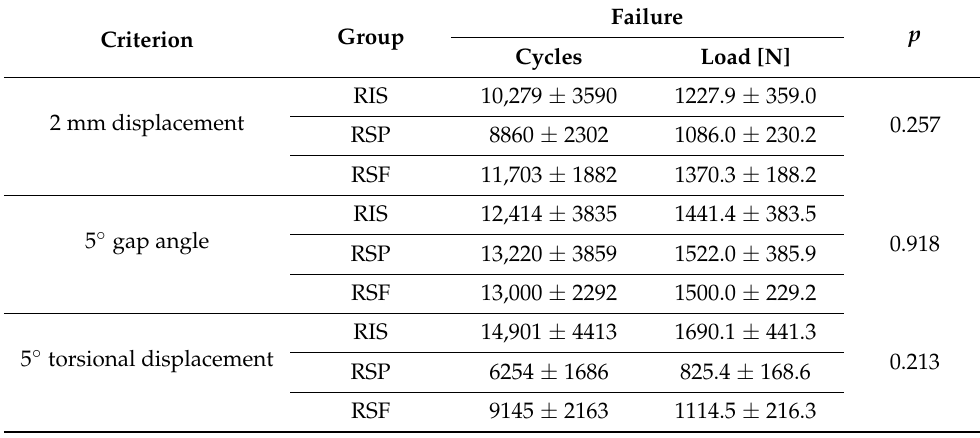
Table 2. Cycles to failure and failure loads until fulfillment of the clinically relevant failure criteria (2 mm displacement, 5 ◦ gap angle, and 5 ◦ torsional displacement), presented for each separate group (RIS, RSP, and RSF) in terms of mean value and standard deviation, together with p -values from the statistical comparisons among the groups ( p